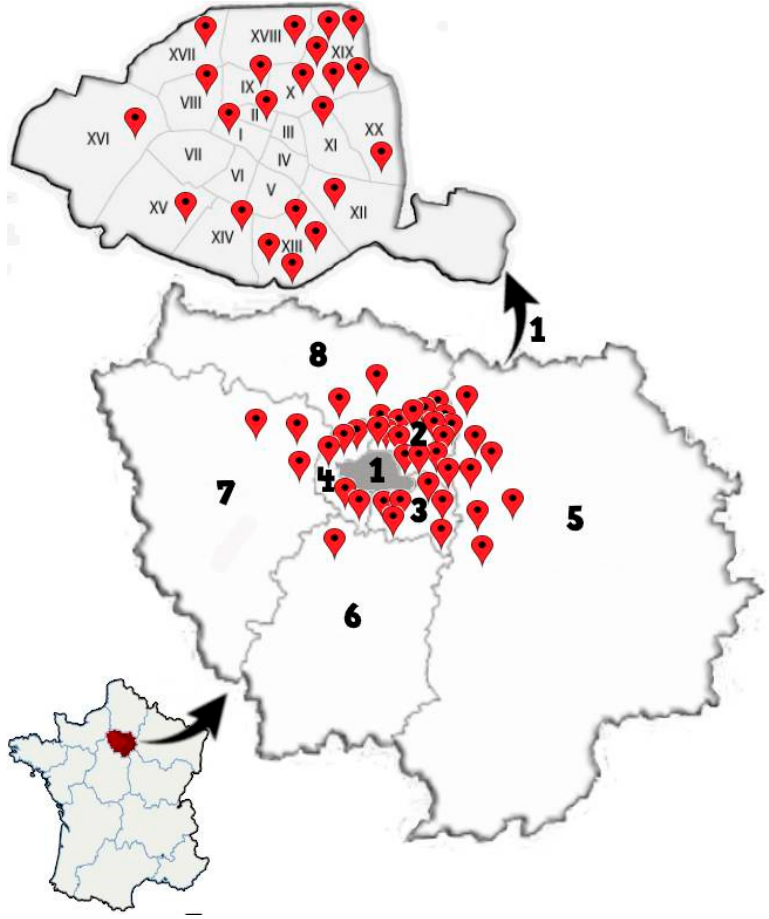
Figure 1. Geographical topology of the processed locations for bed bug sampling in Ile-de-France, France. 1. Paris arrondissements, 2: Seine-Saint-Denis, 3: Val-de-Marne, 4: Hauts-de-Seine, 5: Seine-et-Marne, 6: Essonne, 7: Yvelines, and 8: Val-d’Oise. Table 2. Details of bed bug infestations in various locations observed by visual inspection in Paris and suburb cities.